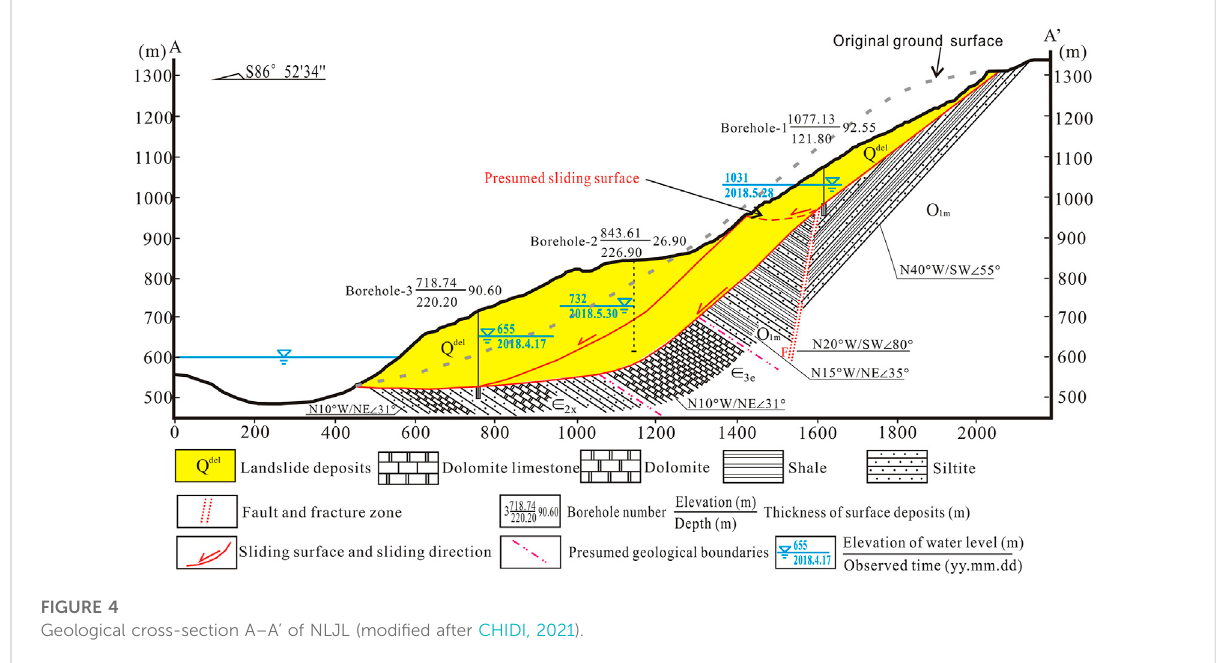
FIGURE 4 Geological cross-section A – A ’ of NLJL (modi fi ed after CHIDI, 2021).